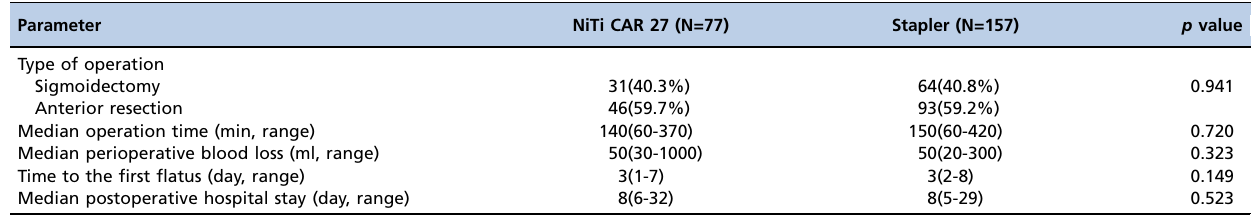
Table 2 - Perioperative data of the patients receiving compression and stapled anastomosis. Parameter